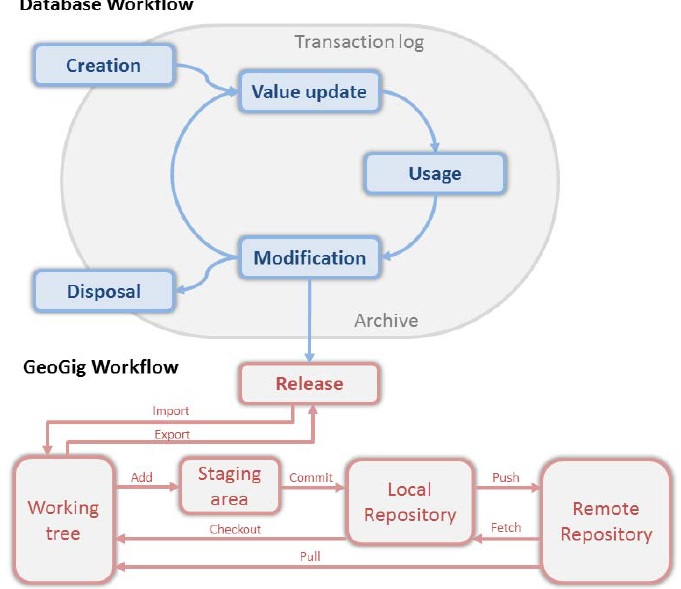
Figure 4. Schematic information life cycle depicting the information flow as supported by the database model. The model is coupled with Git and GeoGig for the versioned release of database states.